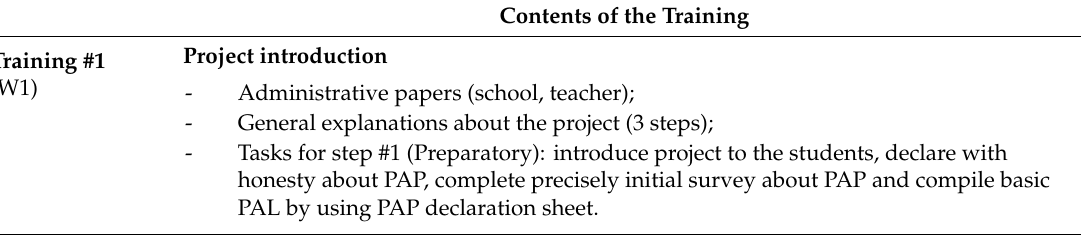
Table A1. Summary of Contents for Team Pentathlon Training